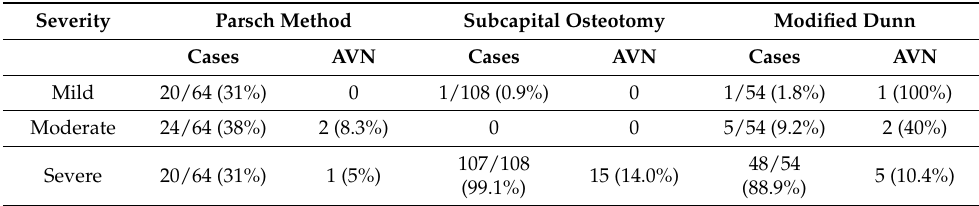
Figure 3. Subgroup analyses of the estimated risk ratios. PIS = pinning in situ, CR(I) = pinning fol- lowing intentional closed reduction, CR(I+UI) = pinning following intentional + unintentional closed reduction, OR = open reduction, SCO = subcapital osteotomy via anterior/anterolateral hip ap- proach. ( A ) Estimated risk ratio in CR(I) and CR(I+UI) versus PIS. ( B ) Estimated risk ratio in PIS versus OR (Parsch method). ( C ) Estimated risk ratio in PIS versus OR (subcapital osteotomy (SCO)). ( D ) Estimated risk ratio in PIS versus OR (modified Dunn). ( E ) Estimated risk ratio in CR(I) and CR(I+UI) versus OR (Parsch). ( F ) Estimated risk ratio in CR(I) and CR(I+UI) versus OR (SCO). ( G ) Estimated risk ratio in CR(I) versus OR (modified Dunn).